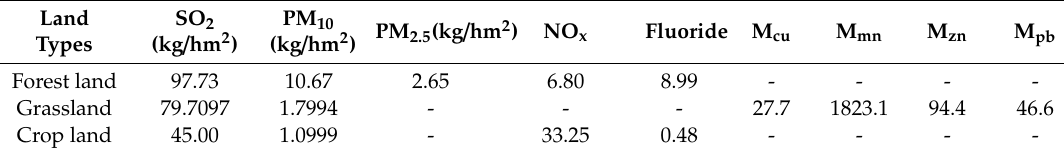
Table A1. The capacities of ecosystems to purify pollutants.